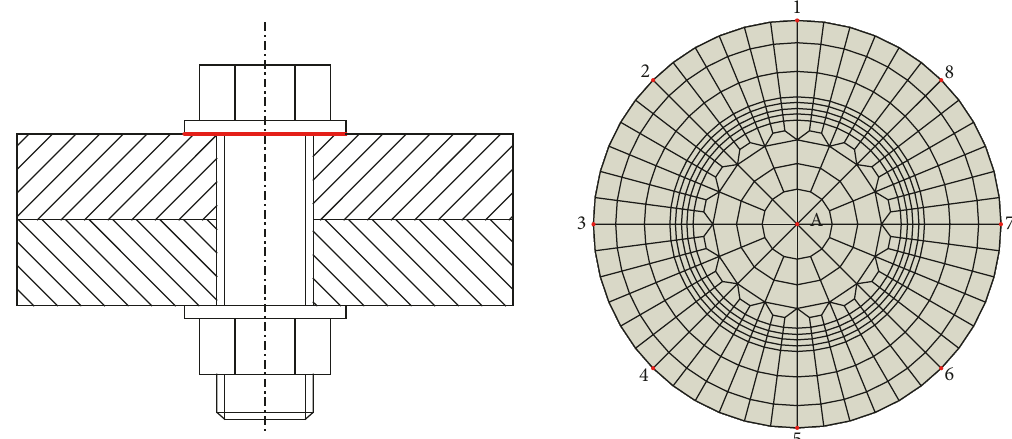
Figure 18: The diagrams of the contact surface and the calculation points.